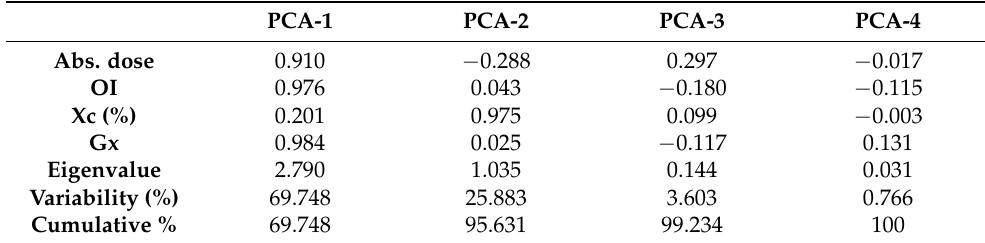
Table 7. Factor loadings of quality